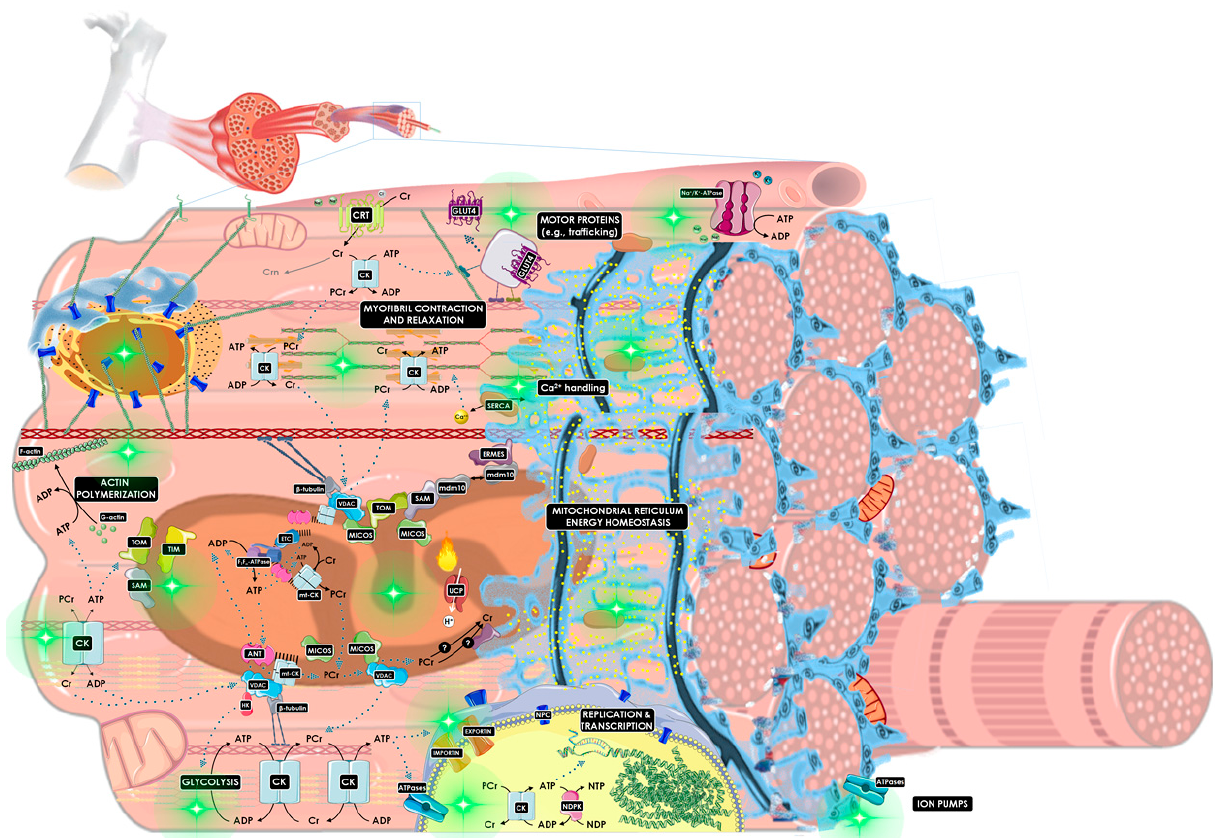
Figure 3. General overview of the CK/PCr system. The diagram represents the super-connected subcellular energy production and cellular mechanics of Cr metabolism. This chemo-mechanical energy transduction network involves structural and functional coupling of the mitochondrial reticulum (mitochondrial interactosome and oxidative metabolism), phosphagen and glycolytic system (extramitochondrial ATP production), the linker of nucleoskeleton and cytoskeleton complex (nesprins interaction with microtubules, actin polymerization, β -tubulins), motor proteins (e.g., myofibrillar ATPase machinery, vesicles transport), and ion pumps (e.g., SERCA, Na + /K + -ATPase). The cardiolipin-rich domain is represented by parallel black lines. Green sparkled circles represent the subcellular processes where the CK/PCr system is important for functionality (see the previous sections for rationale and citations). Several proteins of the endoplasmic reticulum–mitochondria organizing network (ERMIONE), the SERCA complex, the TIM/TOM complex, the MICOS complex, the linker of nucleoskeleton and cytoskeleton complex, and the architecture of sarcomere and cytoskeleton are not depicted for readability. ANT: adenine nucleotide translocase; CK: creatine kinase; Cr: creatine; Crn: creatinine; CRT: Na + /Cl − -dependent creatine transporter; ERMES: endoplasmic reticulum-mitochondria encounter structure; ETC: electron transport chain; GLUT-4: glucose transporter type 4; HK: hexokinase; mdm10: mitochondrial distribution and morphology protein 10; MICOS: mitochondrial contact site and cristae organizing system; NDPK: nucleoside-diphosphate kinase; NPC: nuclear pore complex; PCr: phosphocreatine; SAM: sorting and assembly machinery; SERCA: Sarco/Endoplasmic Reticulum Ca 2+ ATPase; TIM: translocase of the inner membrane complex; TOM: translocase of the outer membrane complex; UCP: uncoupling protein; VDAC: voltage-dependent anion channel. Source: designed by the authors (D.A.B.) using figure templates developed by Servier Medical Art (Les Laboratoires Servier, Suresnes, France), licensed under a Creative Common Attribution 3.0 Generic License. http://smart.servier.com/ (accessed on 14 January